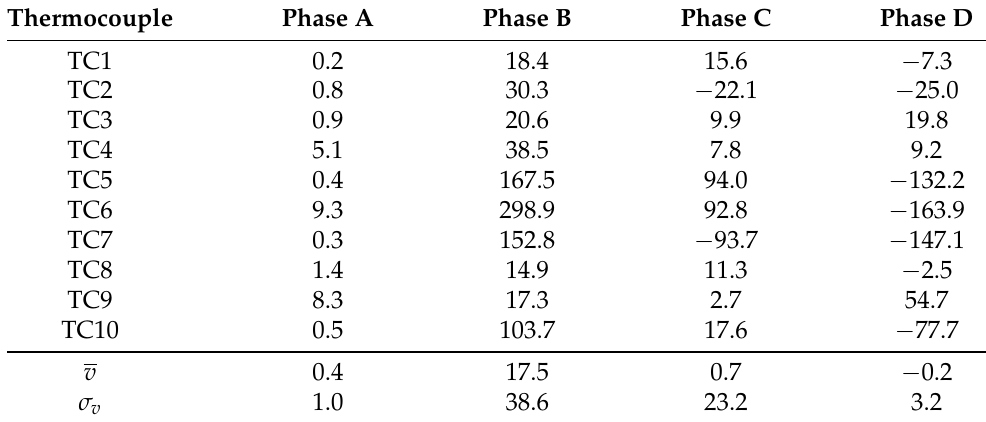
Table 5. Maximal recorded RTC v TC ( ◦ C/s) for all thermocouples and the average RTC in a given phase. Phases A, B, C, and D according to Table 2 and Figure